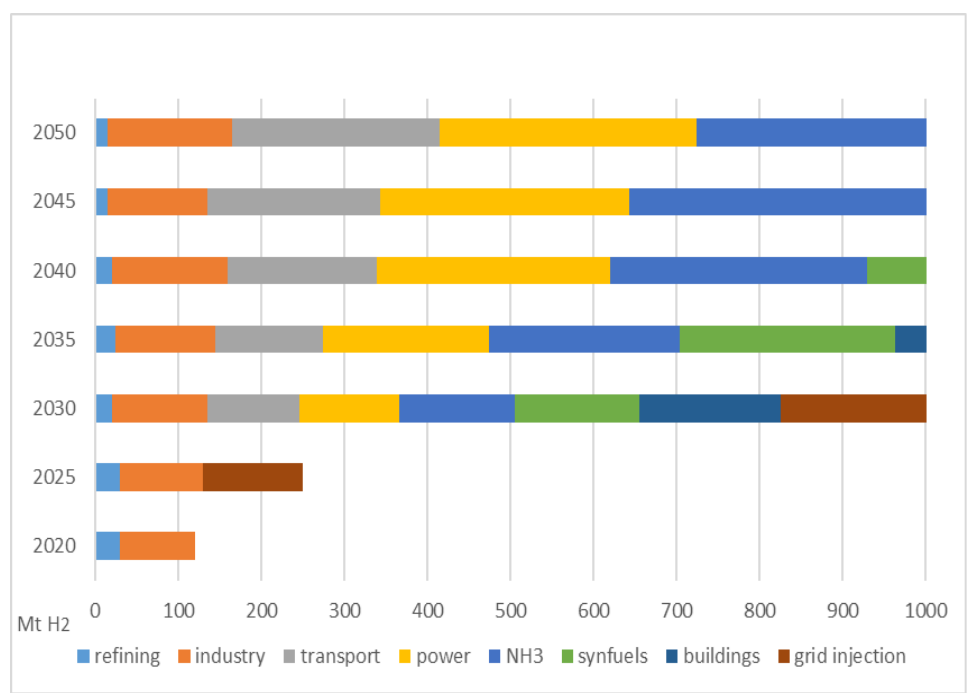
Figure 8. Net Zero Emissions by 2050 [60].